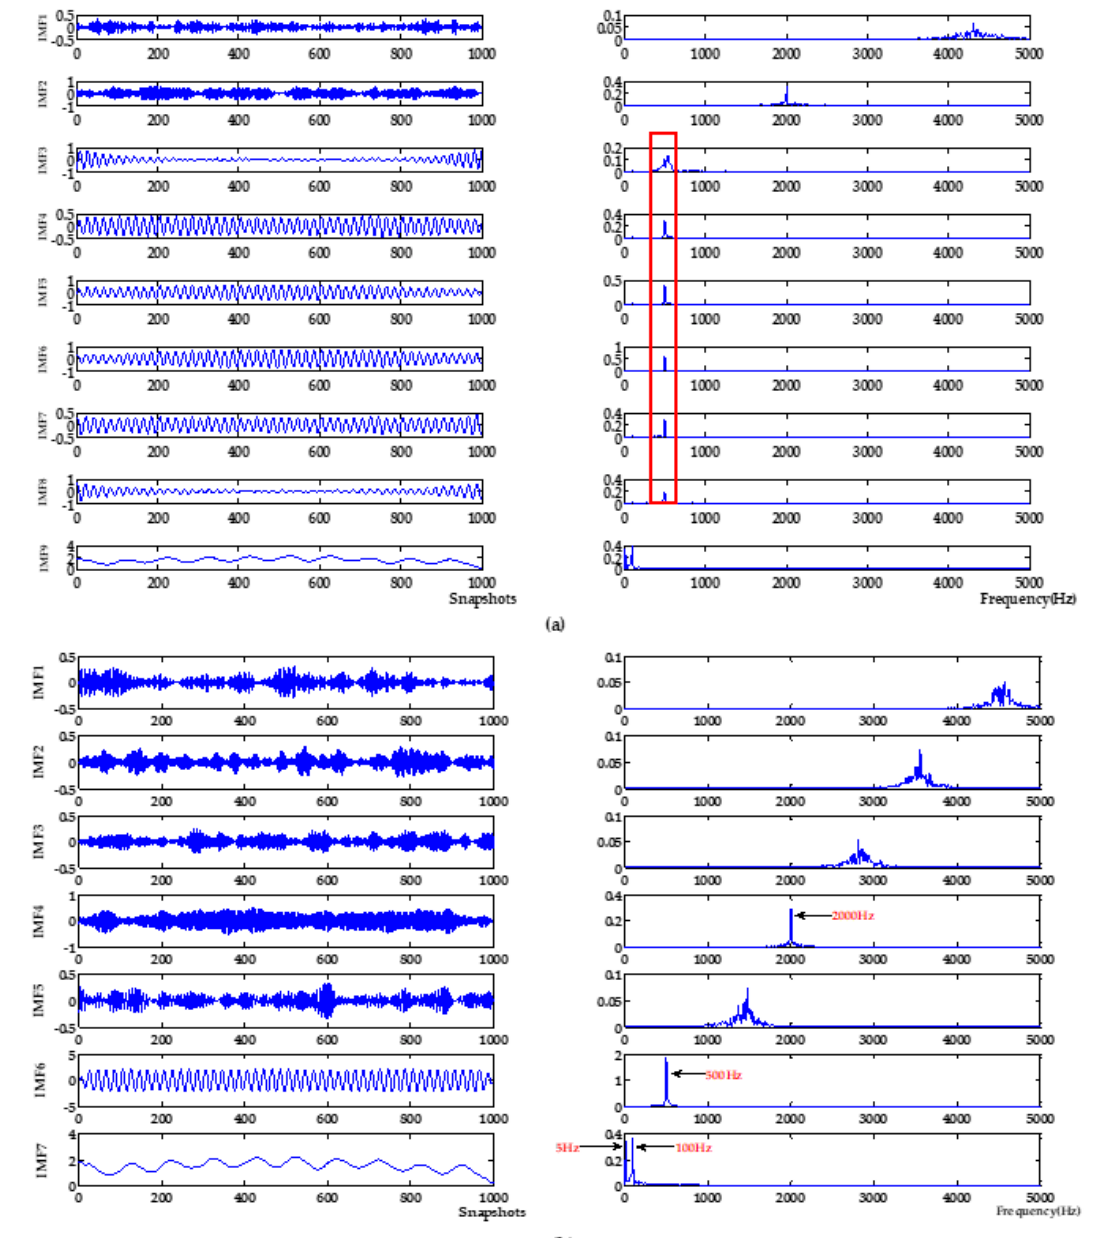
Figure 5. VMD time-frequency diagram with di ff erent parameters. ( a ) K is equal to the decomposition level by EMD, α is the empirical value of 2000. ( b ) Parameters obtained by WOA, K is 7, α is 6240.